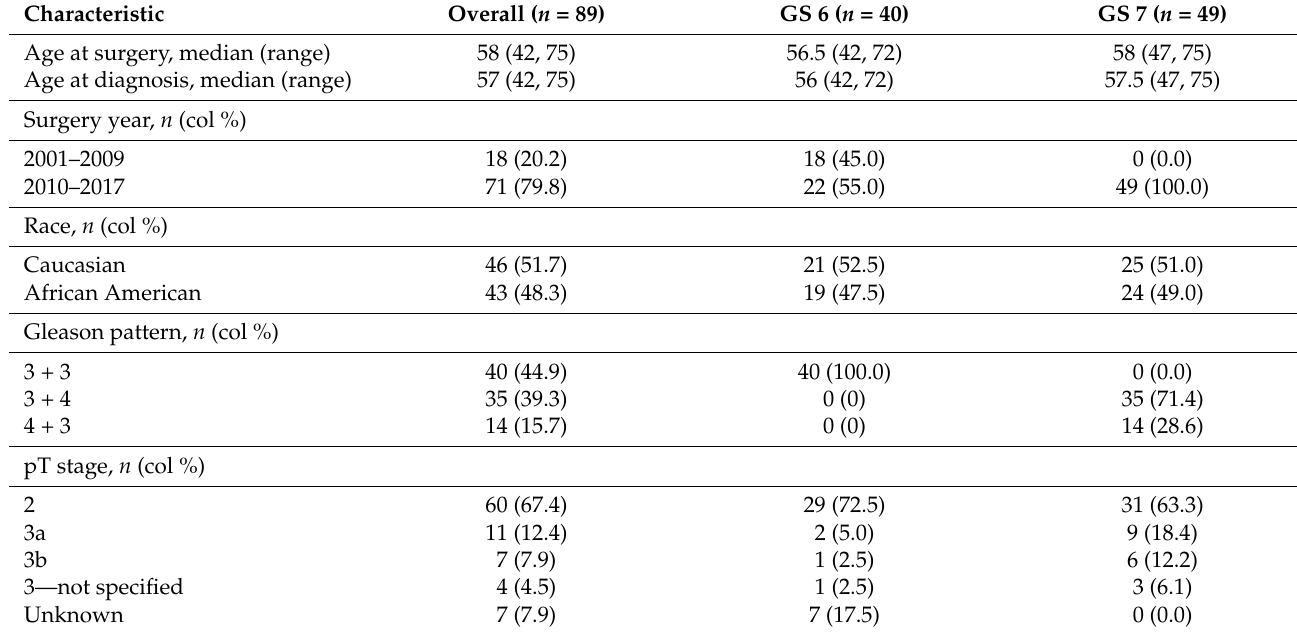
Table 1. Characteristics of radical prostatectomy prostate cancer patients at the University of Maryland Medical Center who had available MYC DNA methylation data, overall and by total